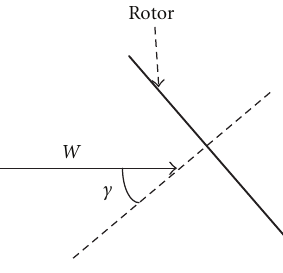
Figure 1: Physical system model. W : wind speed and γ : wind direction angle which is between the wind and the rotor axis.